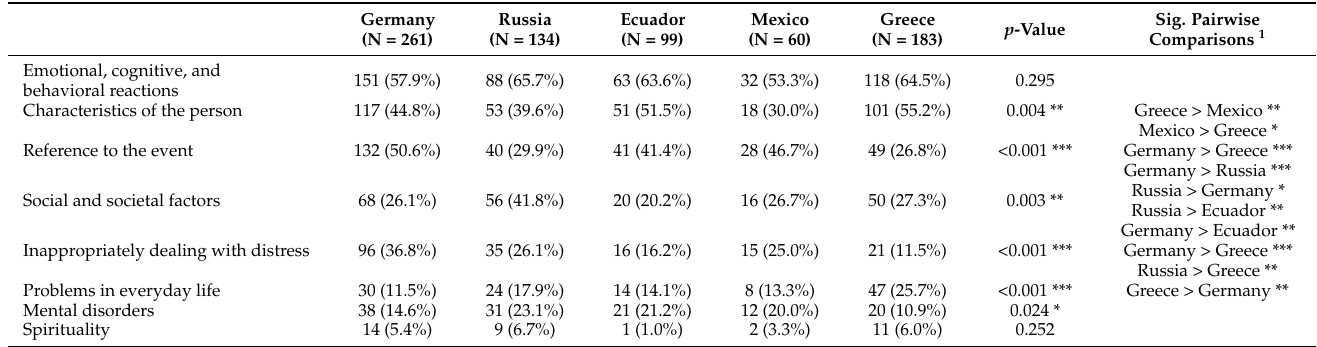
Table 3. Percentage of participants mentioning the second-order theme according to the thematic analysis presented by current country of residence. p -values were calculated with Fisher’s exact test.